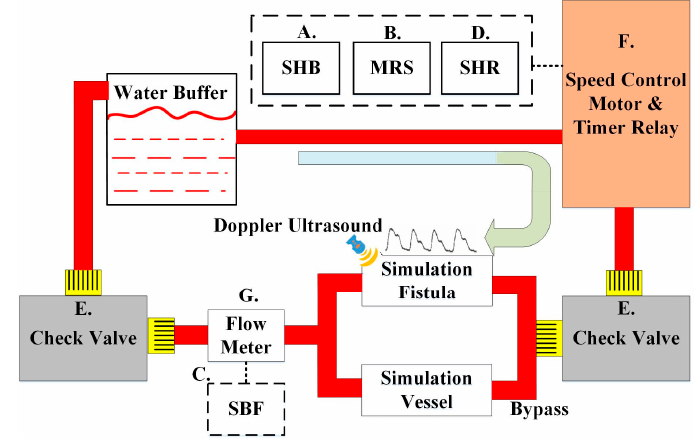
Figure 6 . System block diagram for blood circulation simulation. Figure 6. System block diagram for blood circulation